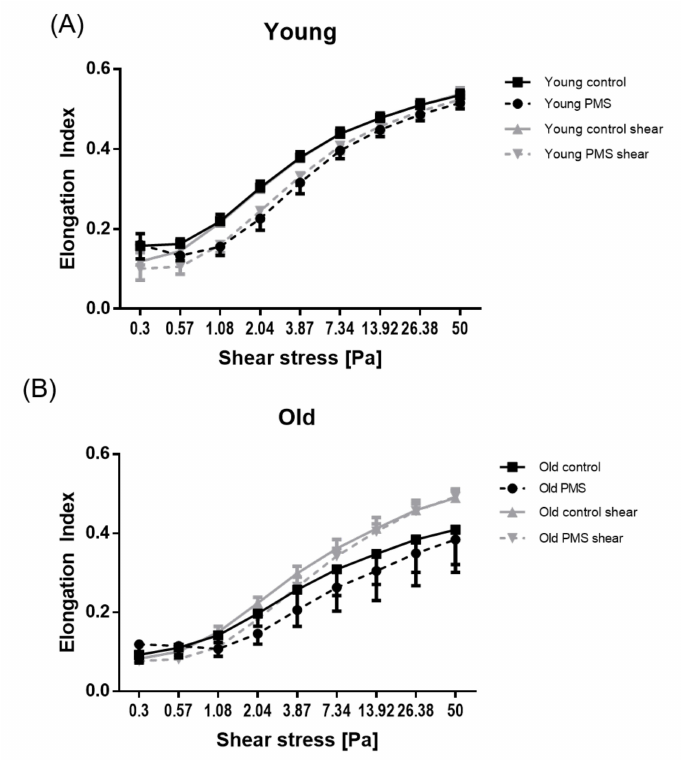
Figure 2. RBC deformability responses to PMS and prolonged shear stress exposure. RBC deforma- bility of young RBCs was significantly higher than of old RBCs. ( A ) Deformability of young RBC was significantly reduced after PMS incubation but was not affected by shear stress. ( B ) Deformability of old RBCs was significantly reduced by PMS, but increased after shear stress application; the combination of both PMS and shear stress also led to an increase in RBC